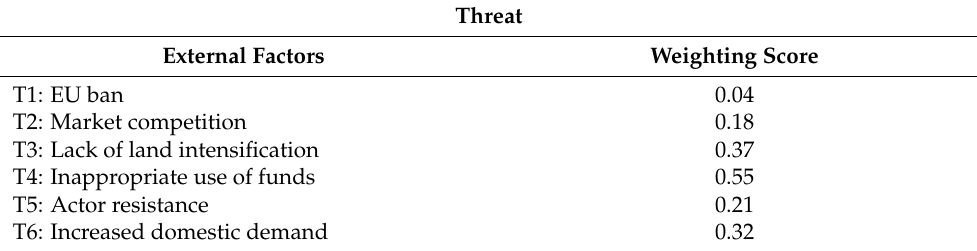
Table 7. Threats challenging the adoption of DBH